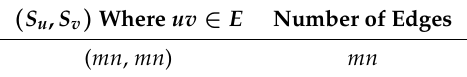
Table 11. Edge partition of K m , n on the basis of degree sum of neighbors of end vertices of each